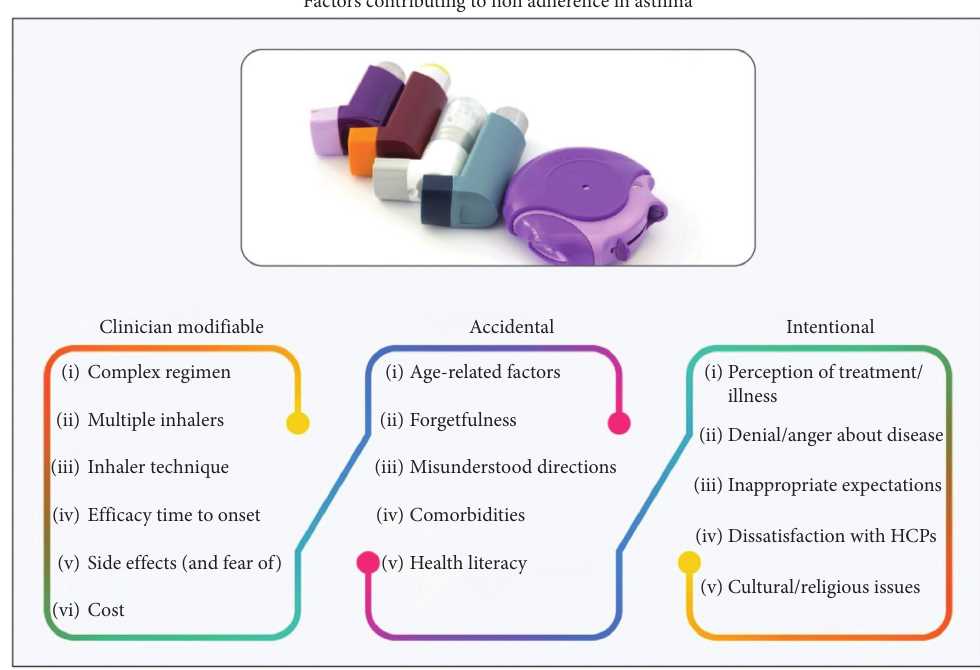
Figure 2: Factors contributing to medication nonadherence in